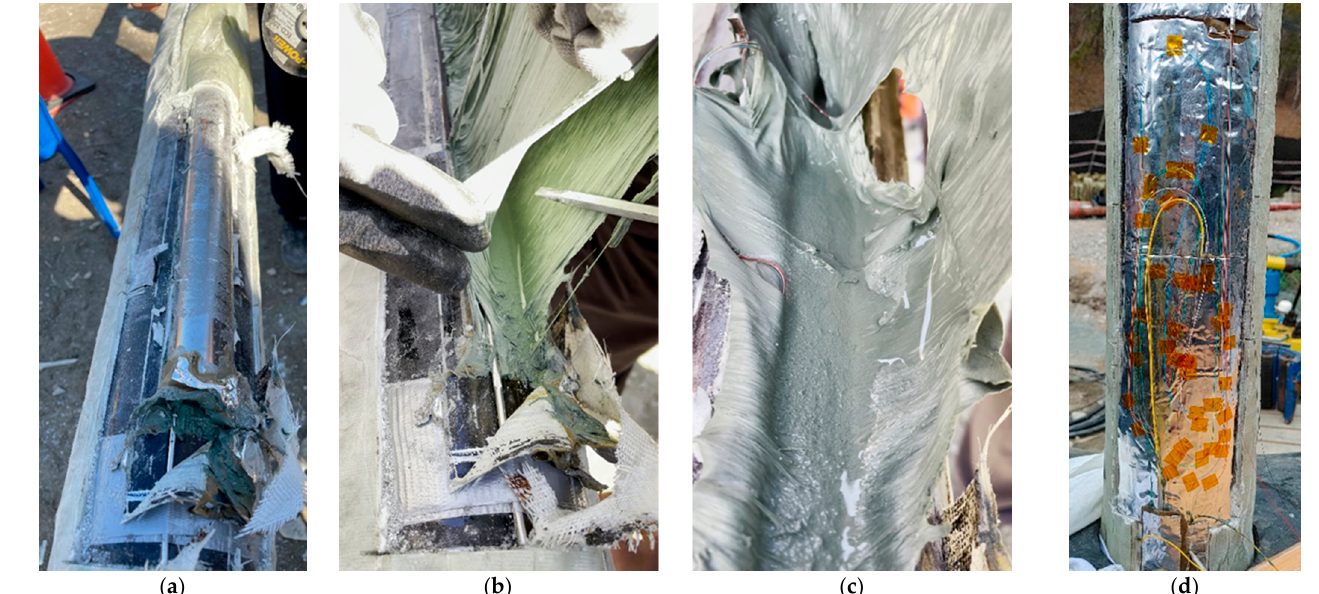
Figure 13. Identification of the reason for the optical fiber damage of the optical fiber fusion connection part and the changed optical fiber fusion connection part; ( a ) FRP removal; ( b ) Protective cover removal; ( c ) Optical fiber damage due to the AK22 deformation; ( d ) Optical fiber and fusion connection part placed on top of the ABM75.